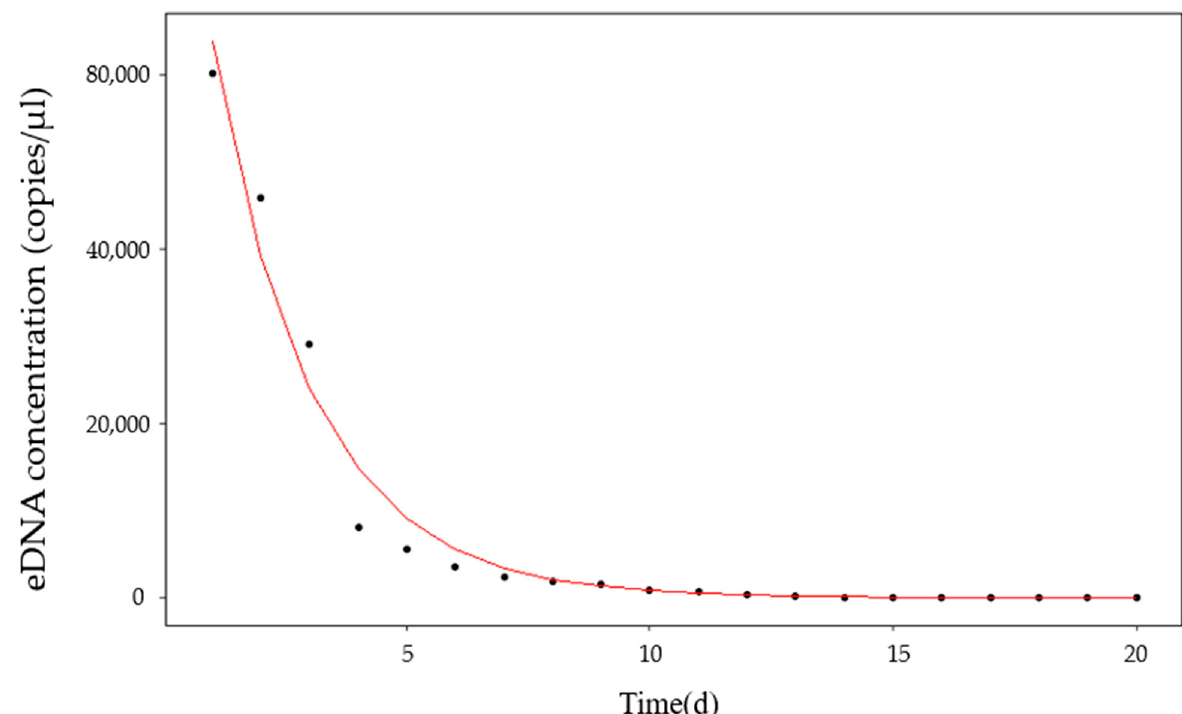
Figure 3. Fitting of the relationship between A. latus eDNA degradation and time . The data points denote the mean eDNA concentration of three replicates. The line represents the exponential decay of eDNA concentration in water with time after the removal of yellowfin seabream.